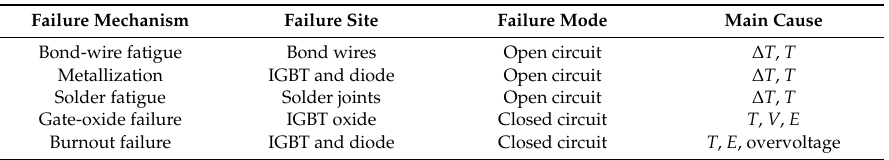
Table 1. Failure mechanism of the IGBT module [23].